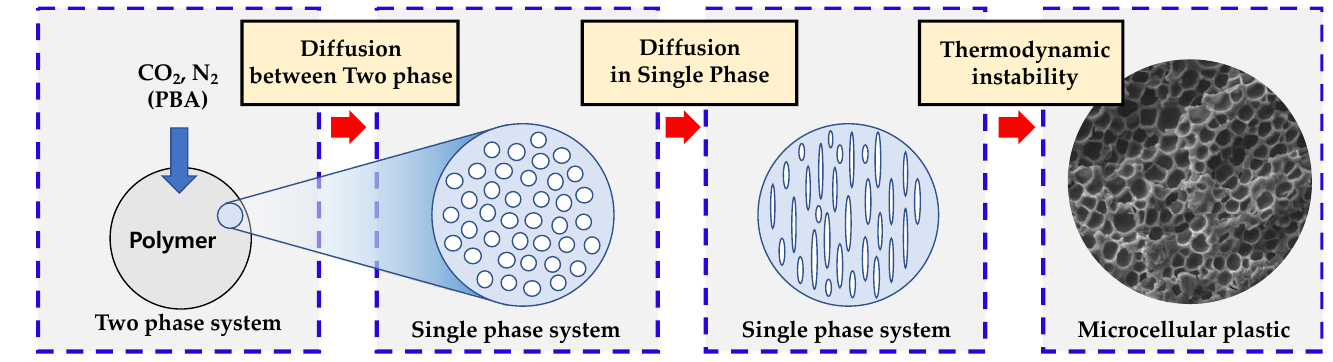
Figure 1. Mechanism of the microcellular-foaming process.